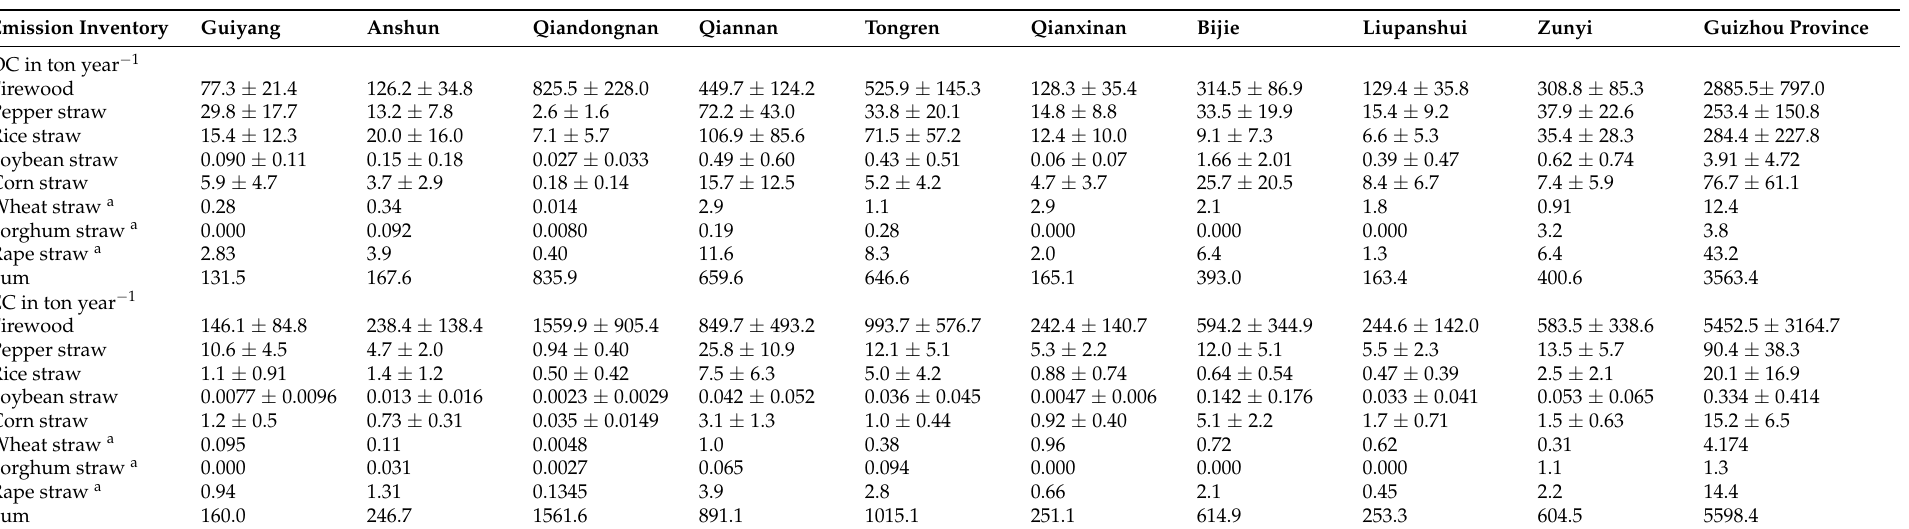
Table 3. Emissions inventory of residential biomass burning in Guizhou Province (unit: tonne year − 1